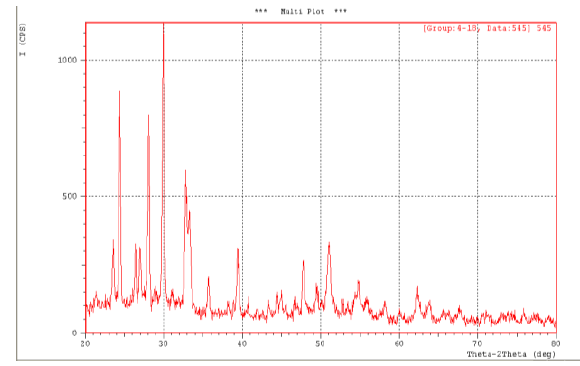
Figure 5: XRD spectrum of nanoparticles synthesized by propolis